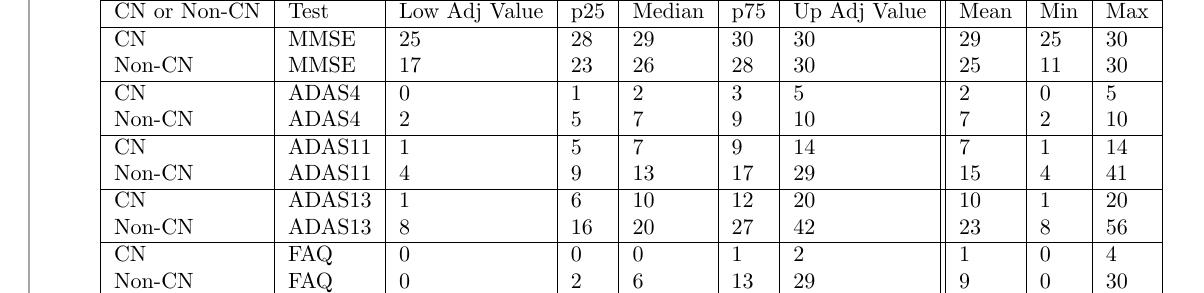
Fig. 4 Ranges of validation data split by the predicted diagnosis (CN or non-CN) assigned by the diagnosis model at month 48 (with normal